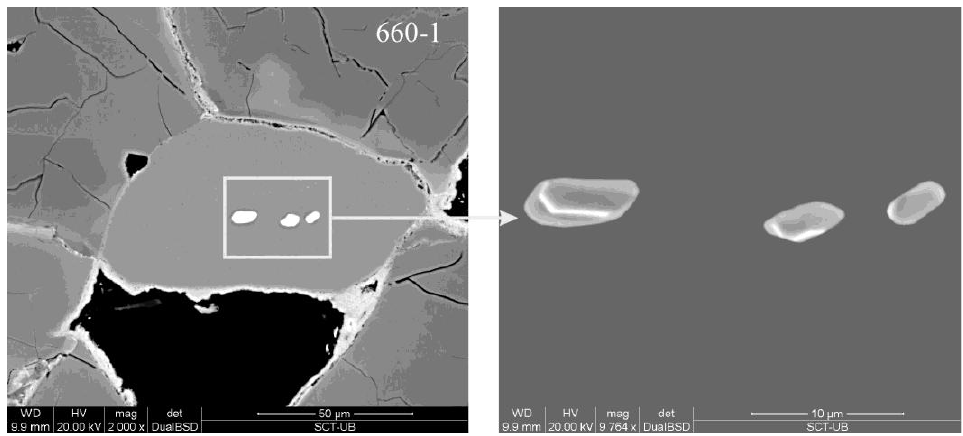
Figure 12. Paragenetic assemblages of Ru-Os-Ir PGM in the CHR-2 chromitite (BSE images). 660-1: Three laurite grains included in ilmenite; the laurite is strongly zoned showing Os-enriched rim. 456A-10a: Euhedral laurite associated with hematite included in chromite 1. 456A-10b: Sub-euhedral laurite associated with rutile in chromite